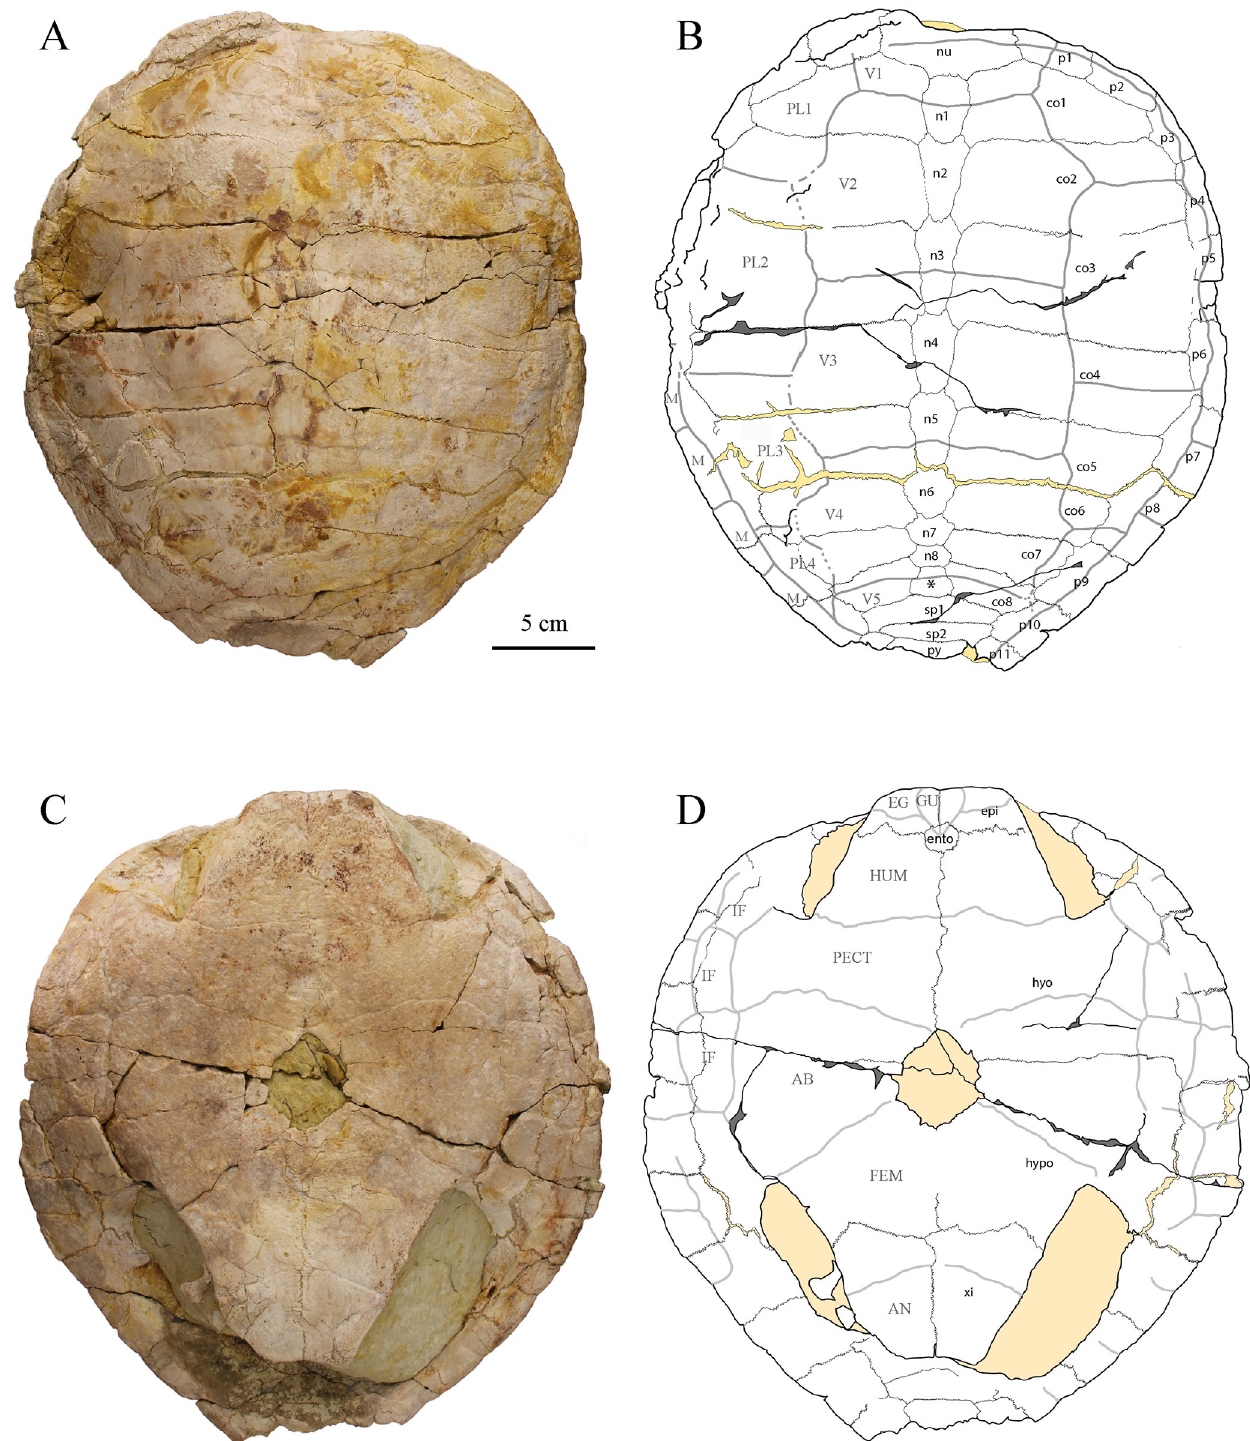
Fig 6. Shell MJSN CBE-0002. A-B: photograph and interpretative drawing of the carapace; C-D: photograph and interpretative drawing of the plastron. Abbreviations: AB, abdominal scale; AN, anal scale; co, costal; EG, extragular scale; ento, entoplastron; epi, epiplastron; FEM, femoral scale; GU, gular scale; HUM, humeral scale; hyo, hyoplastron; hypo, hypolastron; IF, inframarginal scale; M, marginal scale; n, neural; nu, nuchal; p, peripheral; PL, pleural scale; py, pygal; sp, suprapygal; V, vertebral scale; xi, xiphiplastron; � , intermediate element.